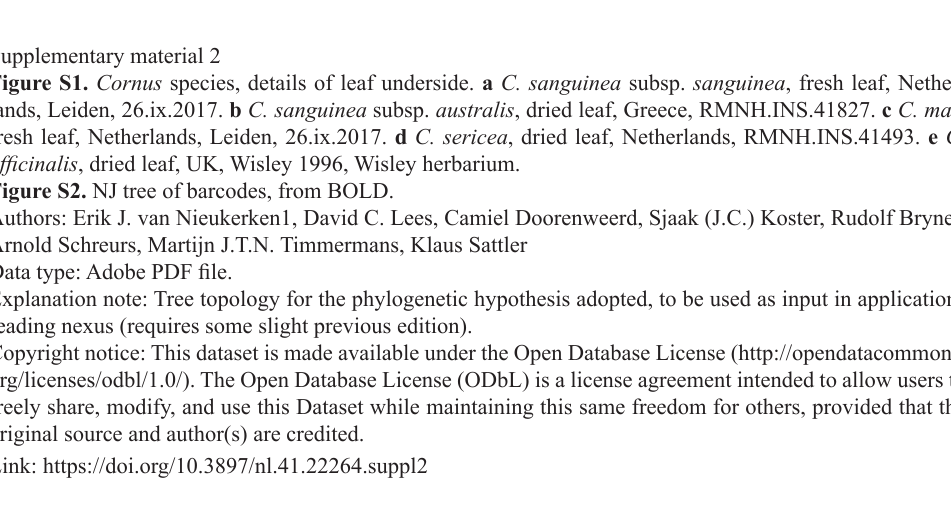
Figure S2. NJ tree of barcodes, from